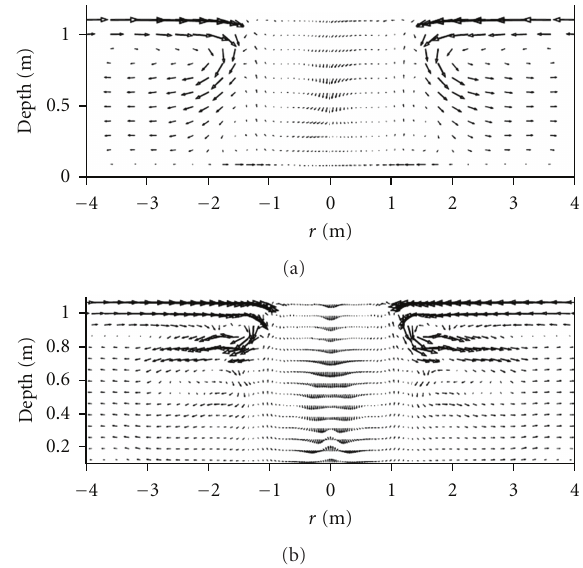
Figure 13: Pattern of secondary current at t = 40 sec by (a) RANS and (b) LES